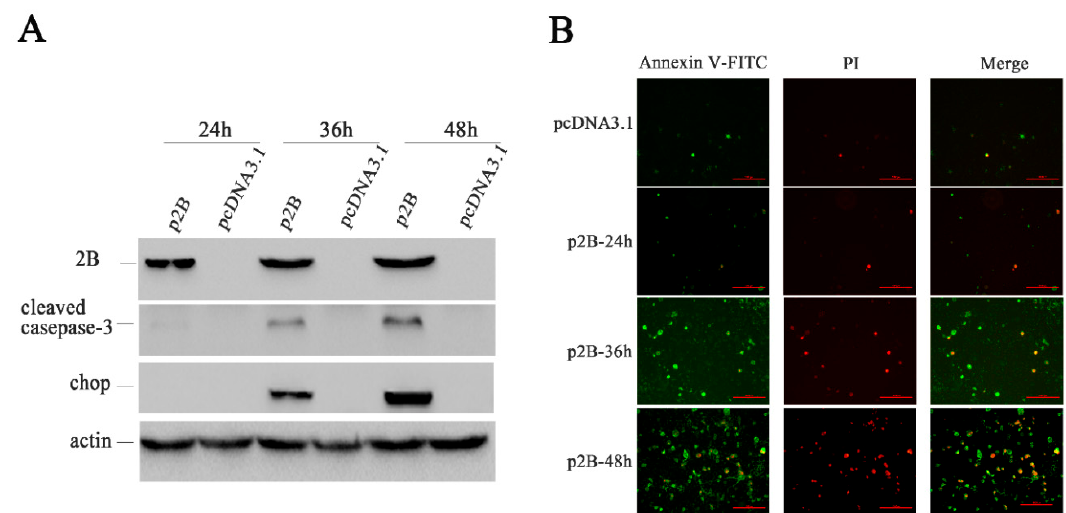
Figure 7. HRV16 2B induced apoptosis. ( A ) The expressions of the 2B protein, cleaved casepase-3, CHOP, and actin were detected in H1-HeLa cells transfected with p2B for 24 h, 36 h and 48 h by Western blotting. Cells transfected with pcDNA3.1 were used as controls. ( B ) After transfection for 24 h, 36 h and 48 h, H1-HeLa cells were stained with FITC-labeled annexin V and PI. Early apoptotic cells are green. Late apoptotic cells are red. Scale bars of images, 200 µ m.